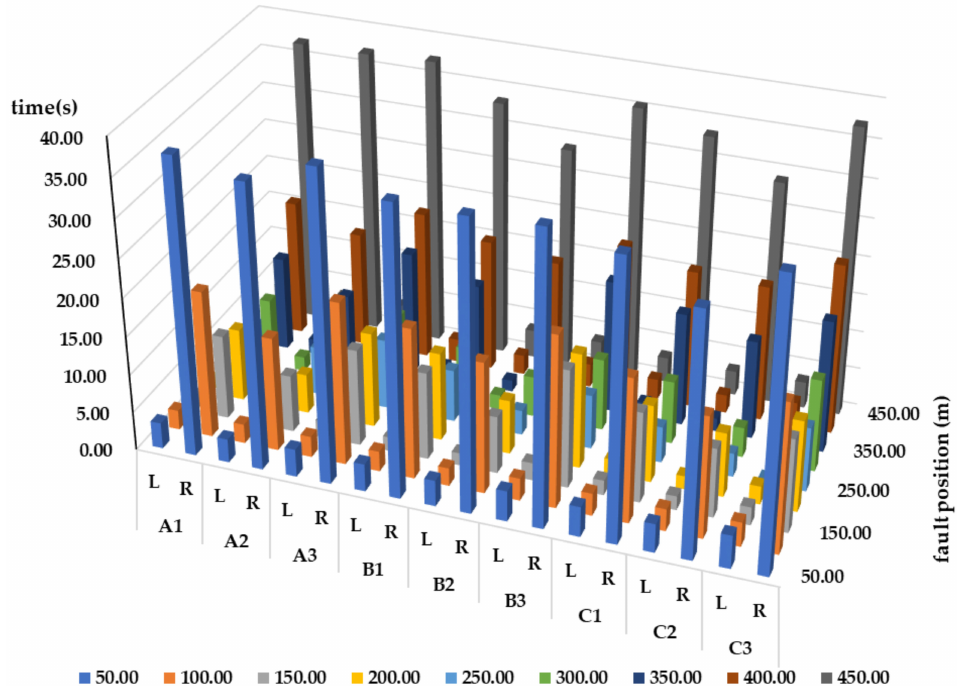
Figure 14. The running time of each simulation. (L represent the method presented in this paper; R represent the algorithm of t-SNE + DBSCAN; A1~C3 represent the cable sections where the fault